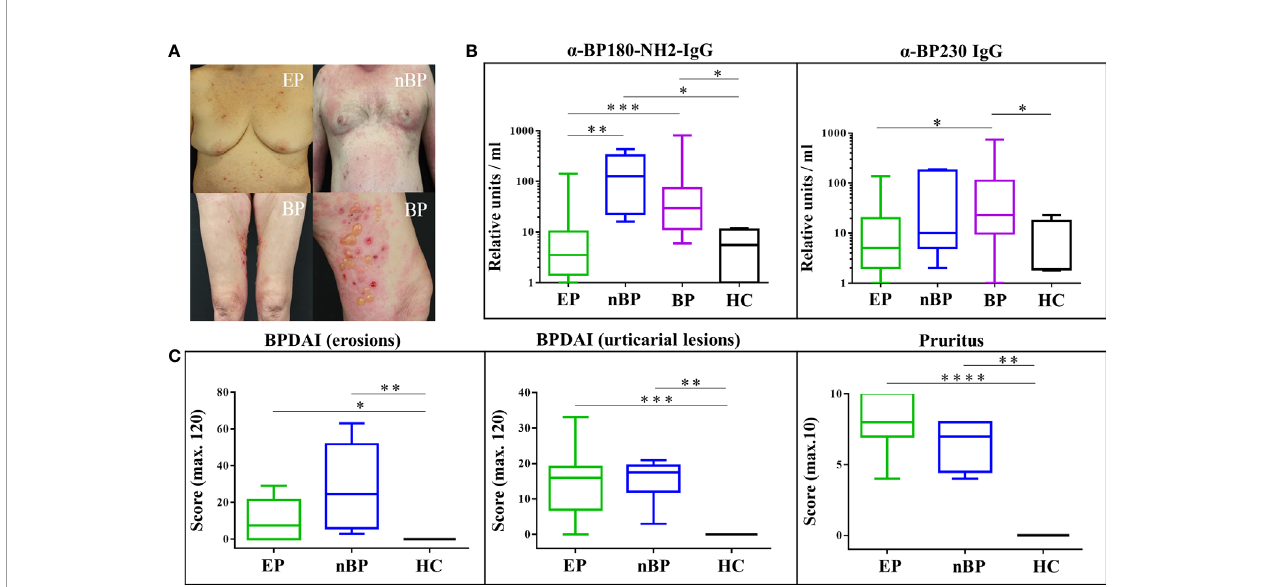
FIGURE 1 | Clinical and immune serological pro fi le of elderly patients (EP) with pruritic disorders, non-bullous pemphigoid (nBP), bullous pemphigoid (BP), and healthy controls (HC). (A) Clinical appearance of EP, nBP and BP. (B) Anti-BP180 and anti-BP230 serum IgG autoantibodies. (C) Bullous Pemphigoid Disease Area Index (BPDAI) and pruritus assessment (severity within the last 24 hours). Statistical analysis of the study groups was performed using Mann – Whitney U-test (*P < 0.05, **P < 0.01, ***P < 0.001, ****P <